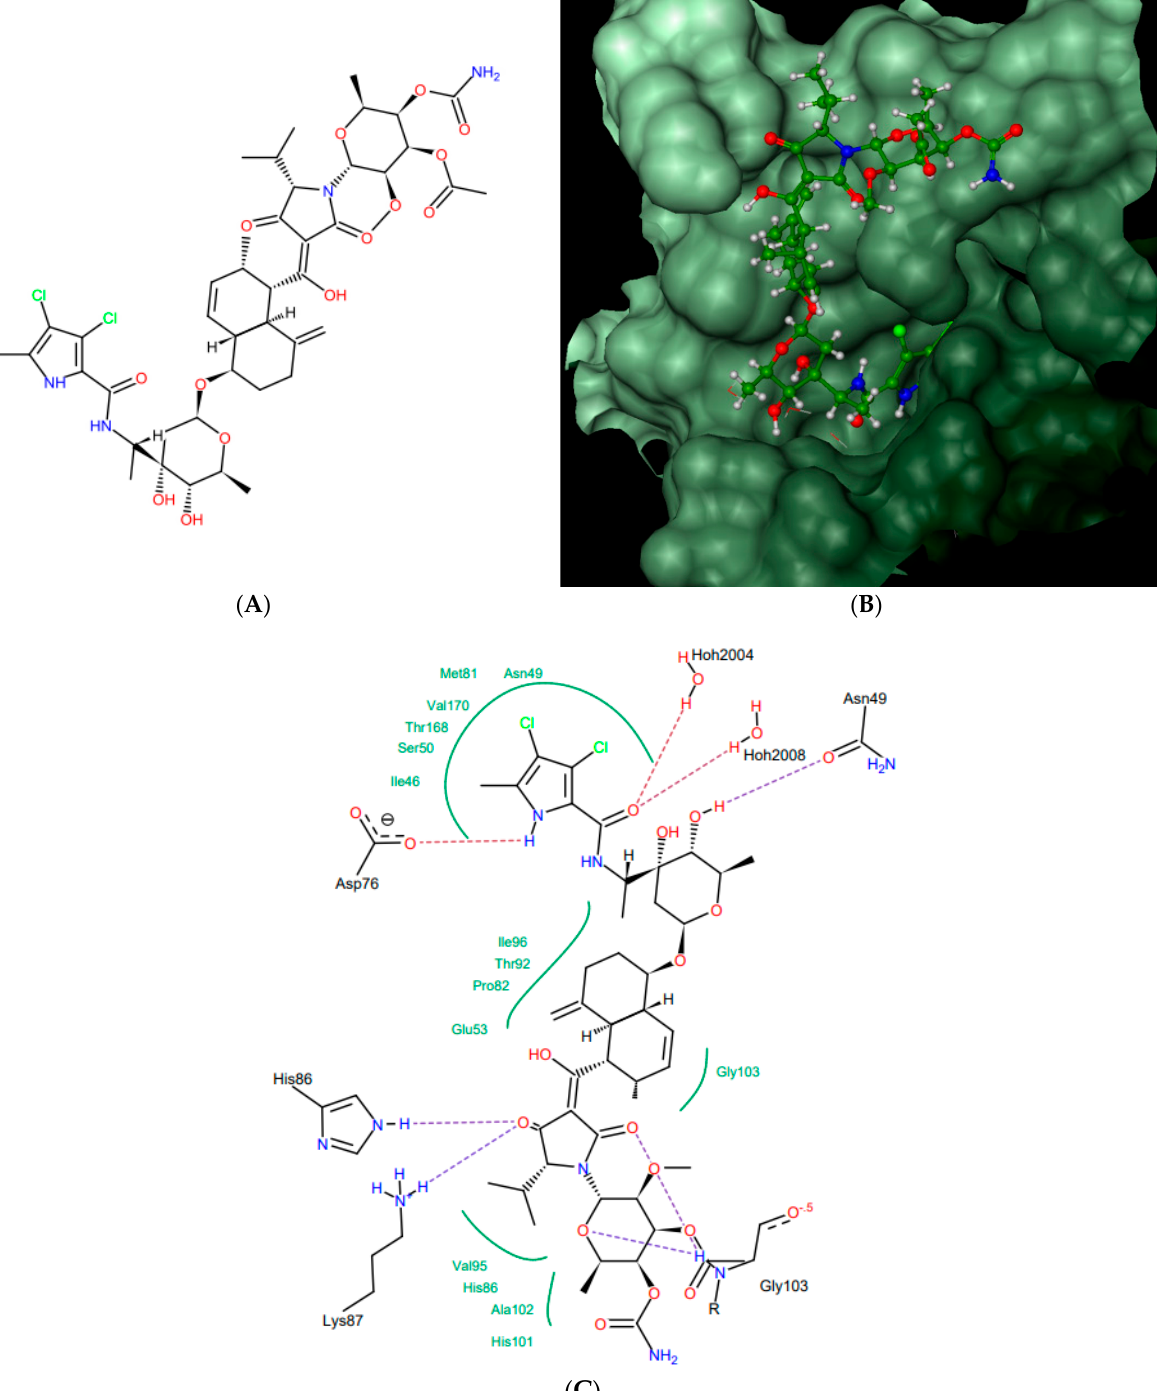
Figure 2. Kibdelomycin: structure ( A ), best pose in binding to S. aureus 43 kDa ParE (Protein Data Bank (PDB) entry: 4URL) ( B ), and interactions with amino acids in the active site ( C ).